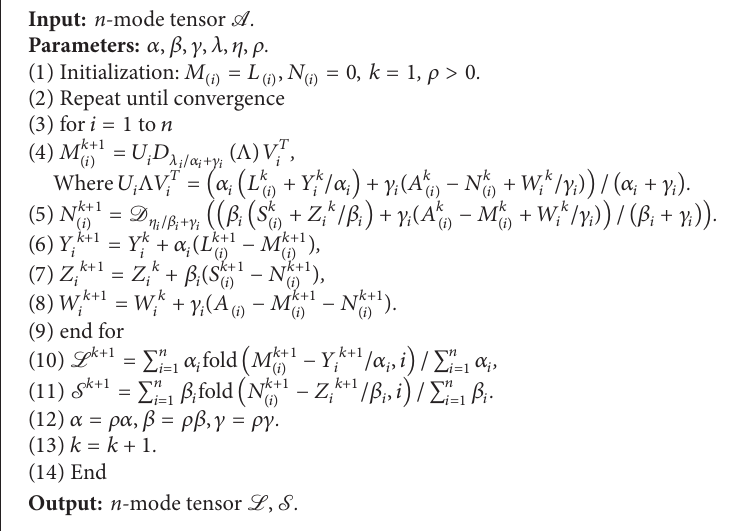
Algorithm 1: MALM-TR: MALM for tensor